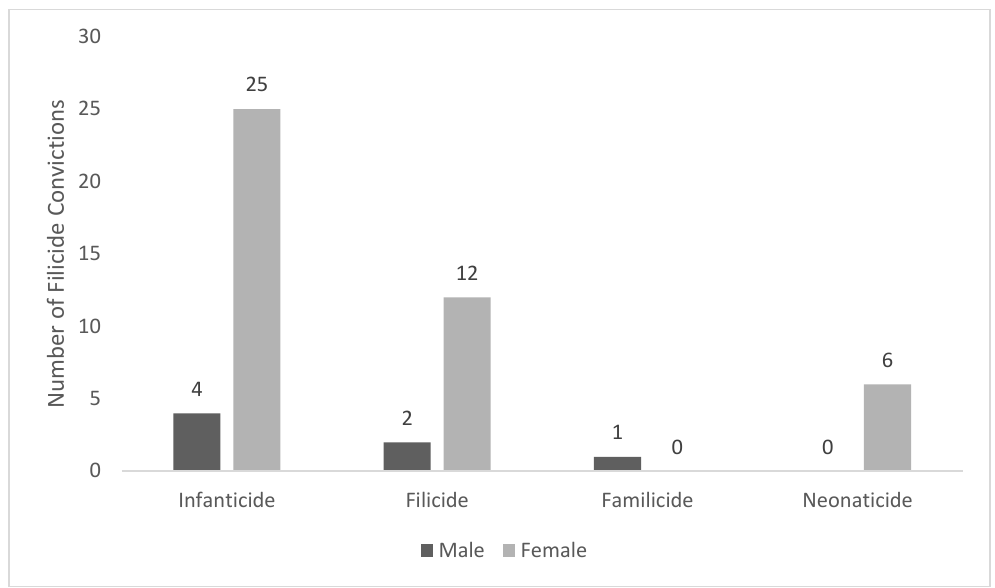
Figure 3: Type of Crime by Sex of Offender in Victoria, 1860 –